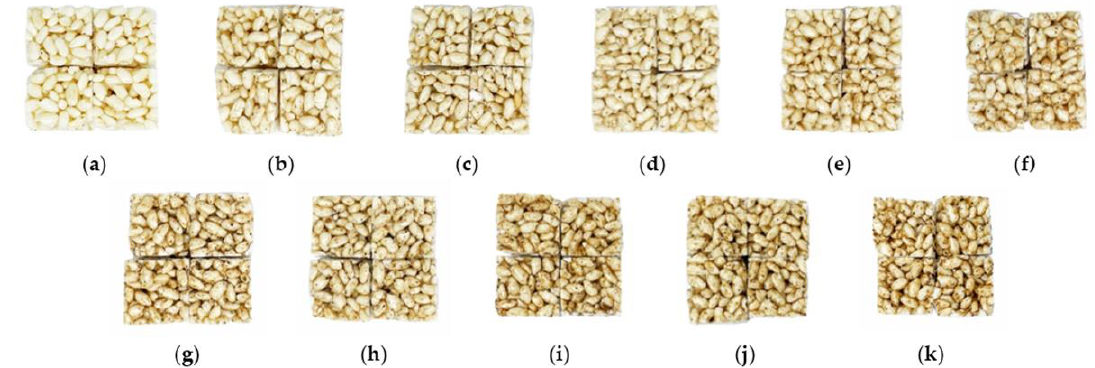
Figure 4. The puffed-rice snacks with different concentrations ( w / w %) of drone pupae powder: ( a ) Control; ( b ) 1%; ( c ) 2%; ( d ) 3%; ( e ) 4%; ( f ) 5%; ( g ) 6%; ( h ) 7%; ( i ) 8%; ( j ) 9%; ( k ) 10%.